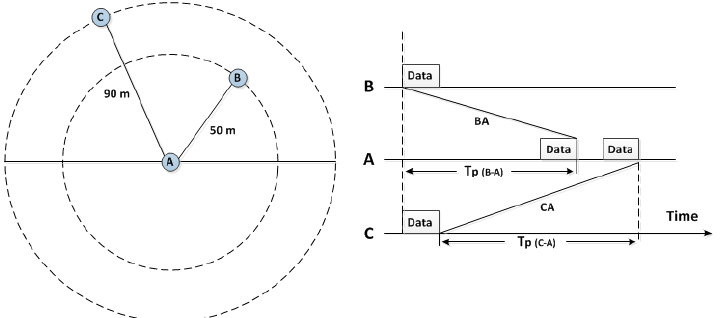
Figure 1. An example of two sender nodes ( B and C ) simultaneously send packets to node A in the same time slot and their transmitted packets arrive at node A with no collision due to the distance differences of sender-receiver